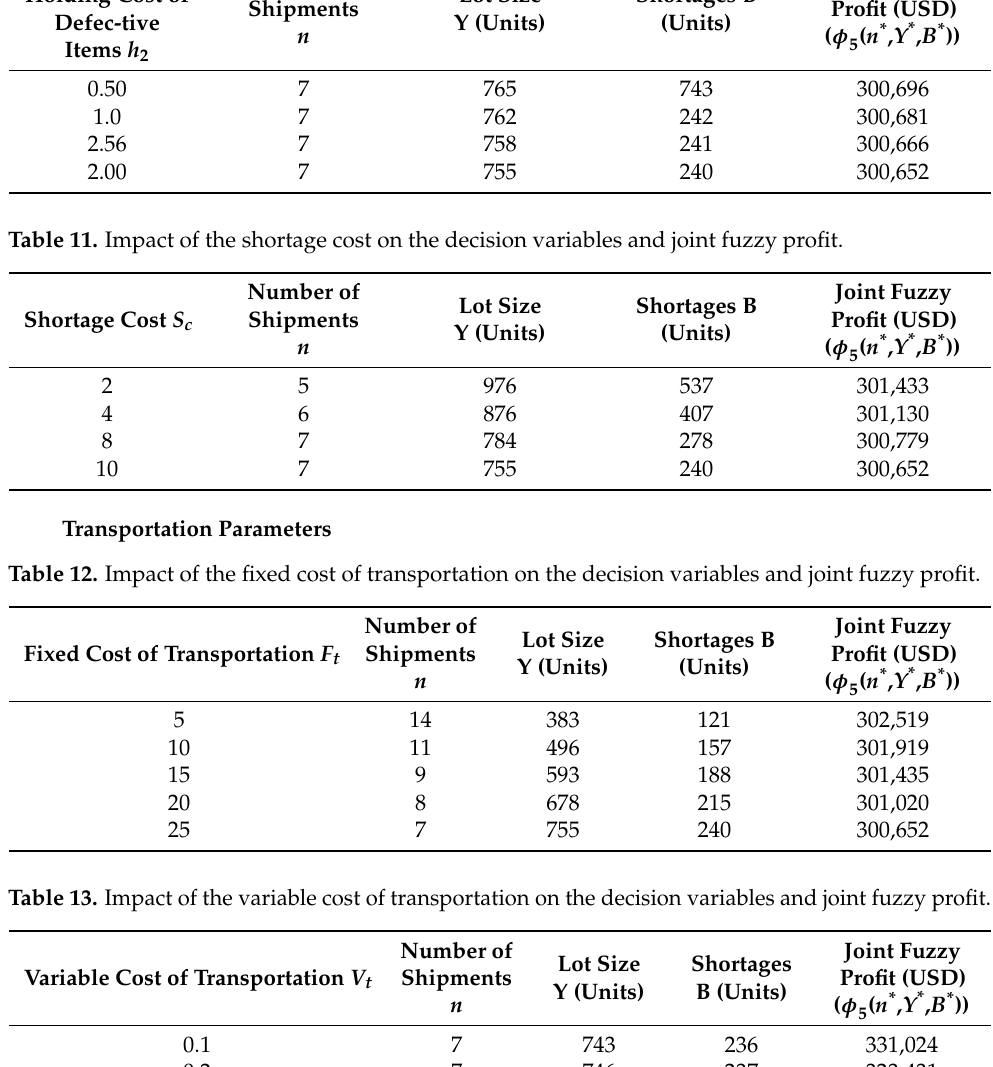
Variable Cost of Transportation V t